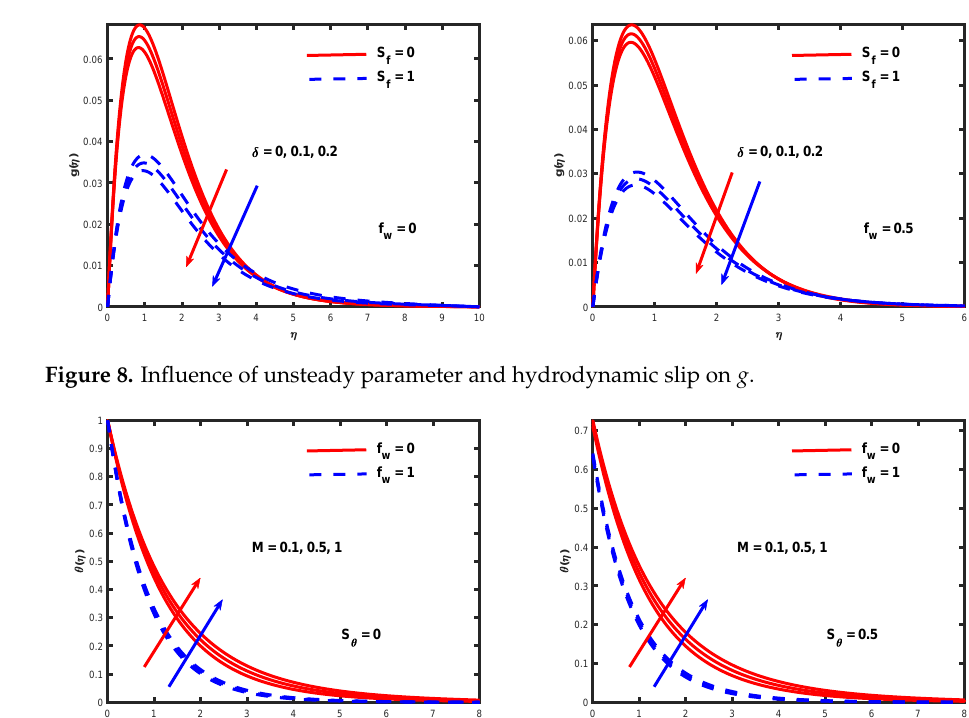
Figure 7. Influence of material and suction/injection parameter on g .